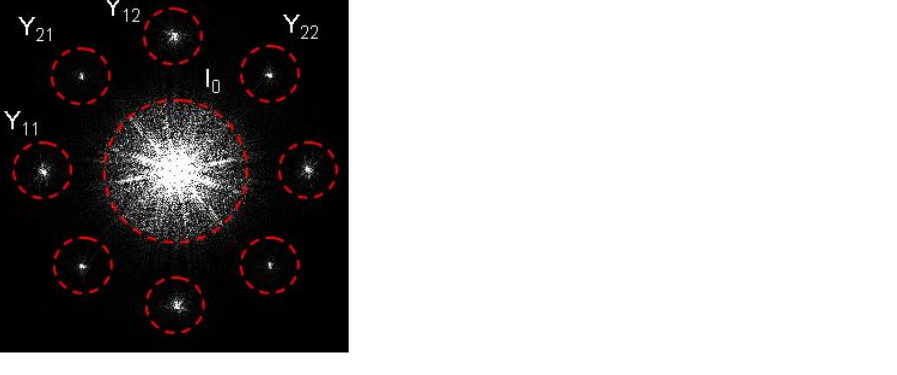
Figure 2. Schematic diagram of spatial spectrum distribution of the four-channel AMPH.